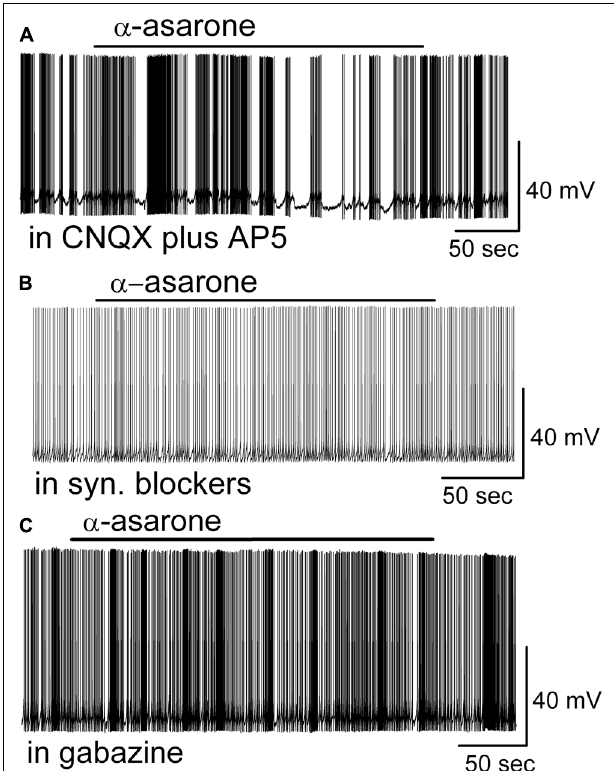
FIGURE 5 | (A–C) A GABA A receptor antagonist rather than AMPA/kainate or NMDA receptor antagonists blocked the α -asarone-induced inhibition of MCs. (A) Original recording obtained from a MC shows that α -asarone-induced suppression of neuronal firing recorded in a representative MC in the presence of iontropic glutamate receptor antagonists CNQX and D-AP5. (B) Current trace shows that α -asarone failed to evoke the inhibitory effects in the presence of fast synaptic blockers. (C) In gabazine, a GABA A receptor antagonist, the firing rate remained the same. Current trace shows that gabazine eliminated the inhibitory effects of α -asarone.